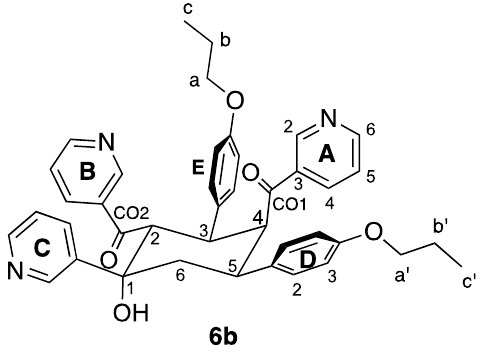
Figure 6. Structure of compound 6b with atom labelling for NMR spectroscopic assignments.